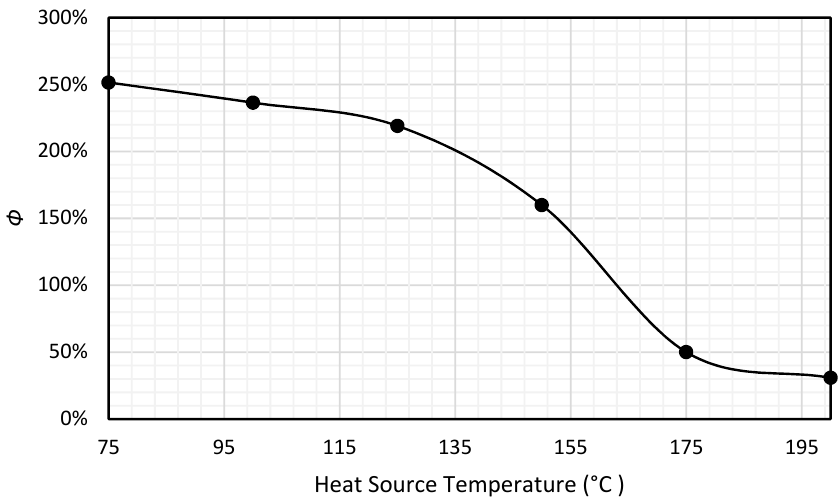
Figure 13. Variation in φ with varying heat source temperature for Beijing’s ambient conditions.